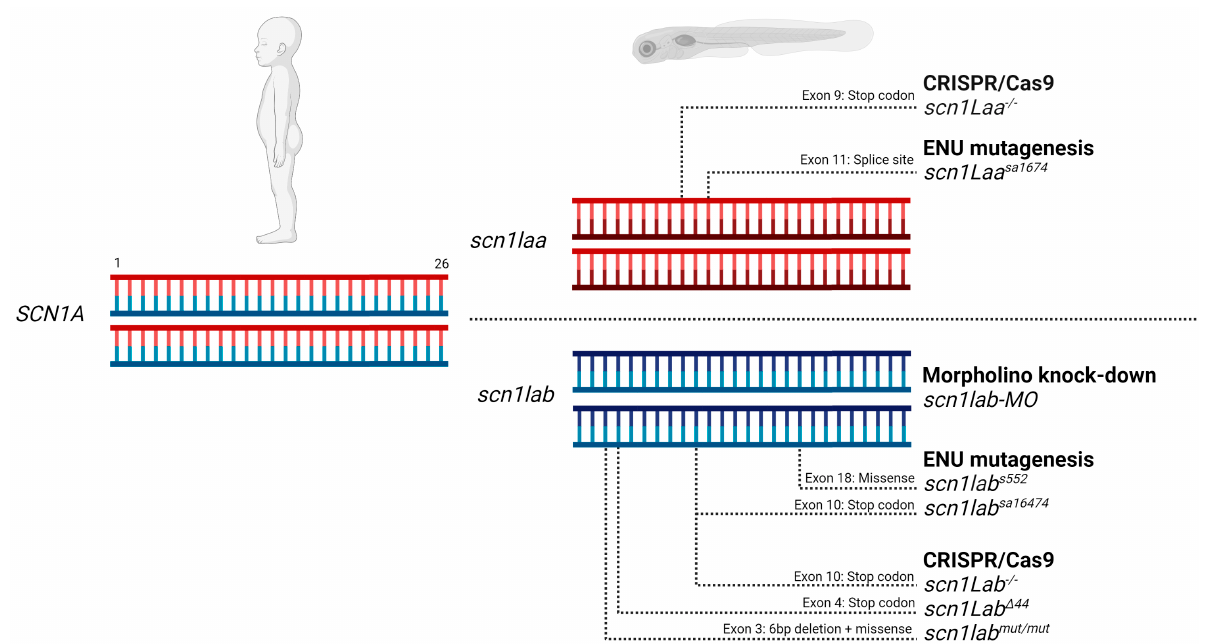
Figure 1. Current zebrafish models for Dravet Syndrome. SCN1A haploinsufficiency in DS patients is modeled by homozygous disruption of one of the two zebrafish paralogs. Disruption is achieved via gene knockdown, missense mutations, or gene knockout introduced by different technologies. References for each model from top to bottom; scn1laa − / − [This publication], scn1laa sa1674 [8], scn1lab MO [3], scn1lab s552 [4], scn1lab sa16474 [9], scn1lab − / − [5], scn1lab ∆ 44 [10], scn1lab mut/mut [1]. Figure made with Biorender .